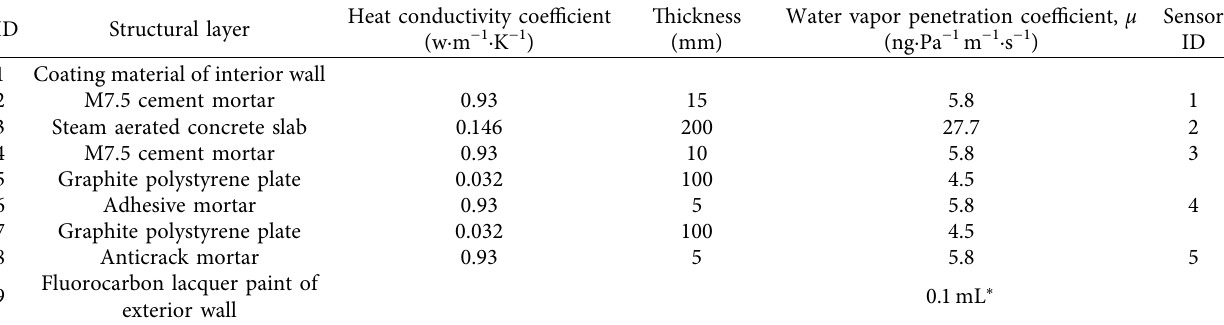
Table 1: Physical property parameters of building materials for the test external wall.